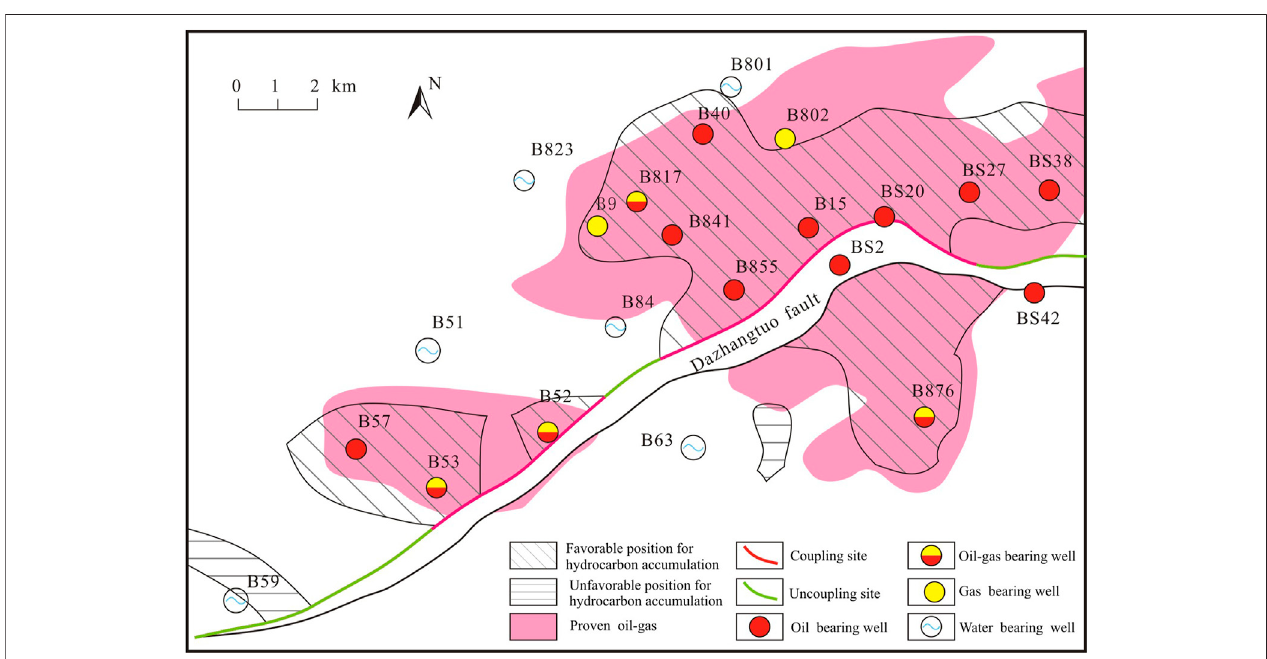
FIGURE 10 | Prediction of favorable positions for hydrocarbon accumulation along the Dazhangtuo fault in the Ban 2 oil group.